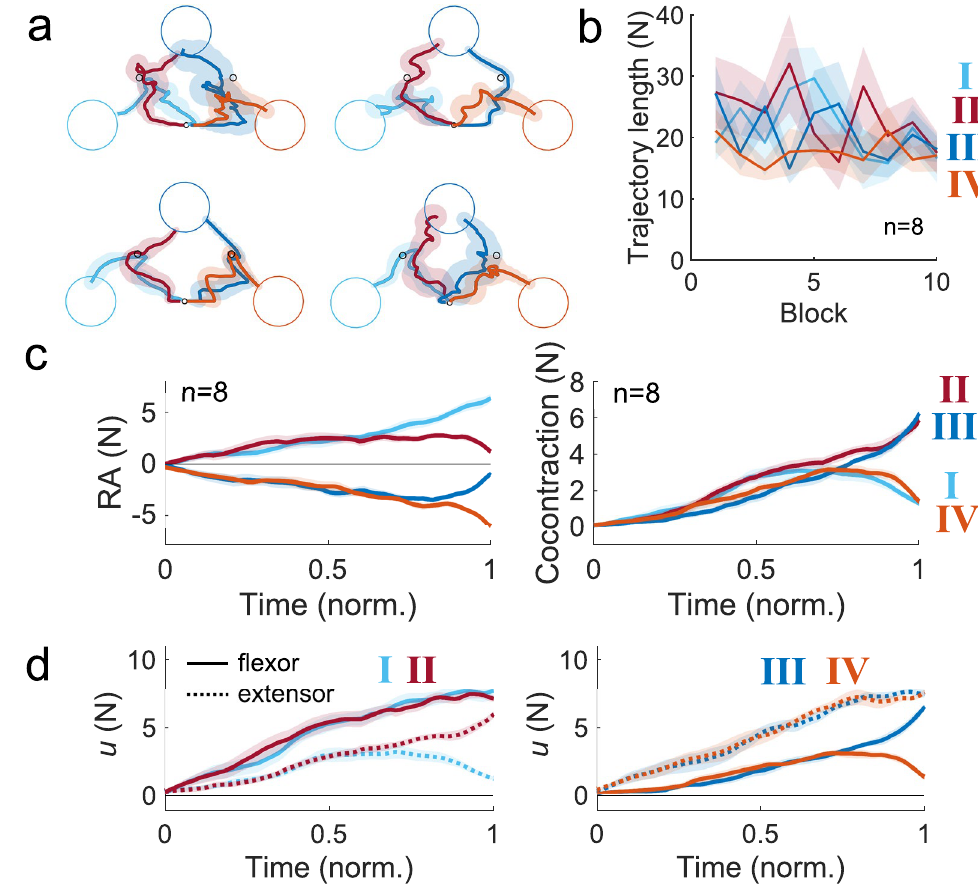
Figure 2. Participants successfully reached the via-point targets by modulating reciprocal activity and cocontraction. ( a ) The trajectory of four representative participants when reaching the four via-point targets is shown in the final phase of the task. Participants were successful at controlling the cursor’s position such that it passed through the via-point target prior to reaching the final target position. ( b ) The group mean length of the trajectories in reaching the four via-point targets as a function of the block number. The trajectory lengths were comparable between all via-point targets, implying that no specific combination of RA and cocontraction was particularly difficult for the nervous system to exert. ( c ) The time-series of the RA and the cocontraction in the via-point task. The increase in cocontraction was similar for all via-point targets, and only branched off in different directions approximately three-quarters of the way into the movement duration. ( d ) The time-series of the estimated shoulder flexor and extensor forces shows how the timely change in the RA occurred near the final half of the trial while the cocontraction was continually